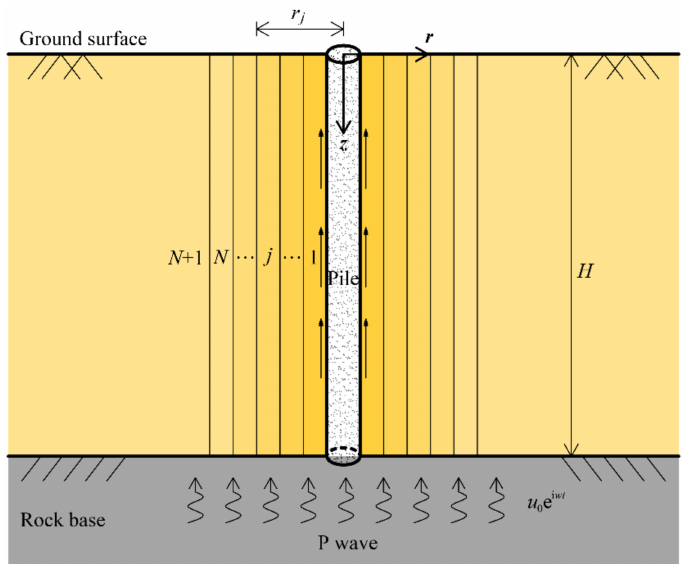
Figure 1. The analytical model of the kinematic response of end-bearing piles under the excitation of vertical P-waves considering the construction